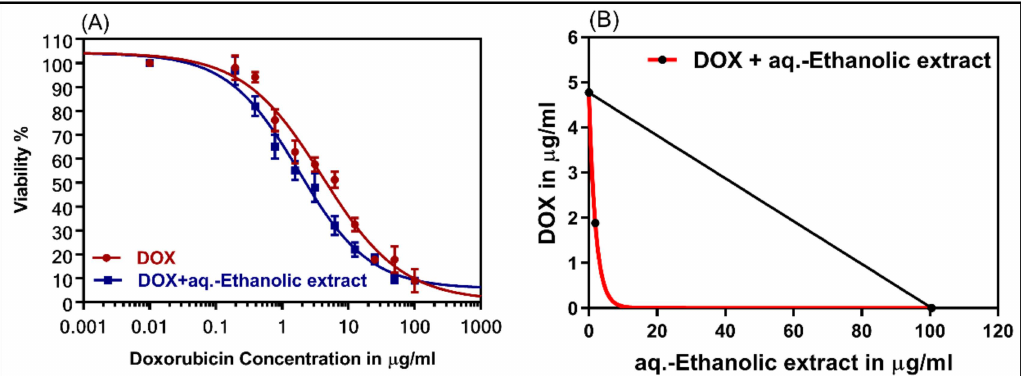
Figure 4. ( A ) The dose-response curves and isobologram analysis of the combination of DOX with 20 µ g / mL of Suaeda vermiculata extract in resistant HepG-2 / ADR. ( B ) The isobologram on the right side of the figure showed the synergistic interaction between DOX and the extract. IC 50 , DOX, and IC 50 extract correspond to the IC 50 for DOX and extract alone. CI < 1 indicates synergism, CI = 1 indicates additive, and CI > 1 indicates antagonism. Table 6. Synergistic interaction of a combination of DOX with 20 µ g / mL of Suaeda